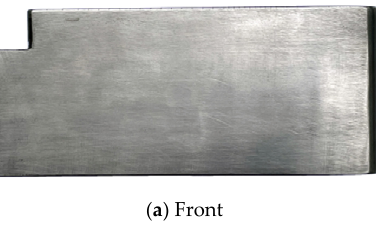
Figure 8. ( a , b ) Before grinding the guide vane.